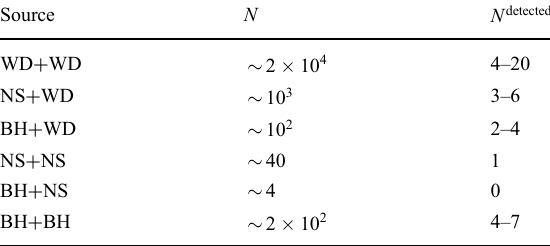
Table 4 Estimated absolute number of compact binaries in globular clusters in the Milky